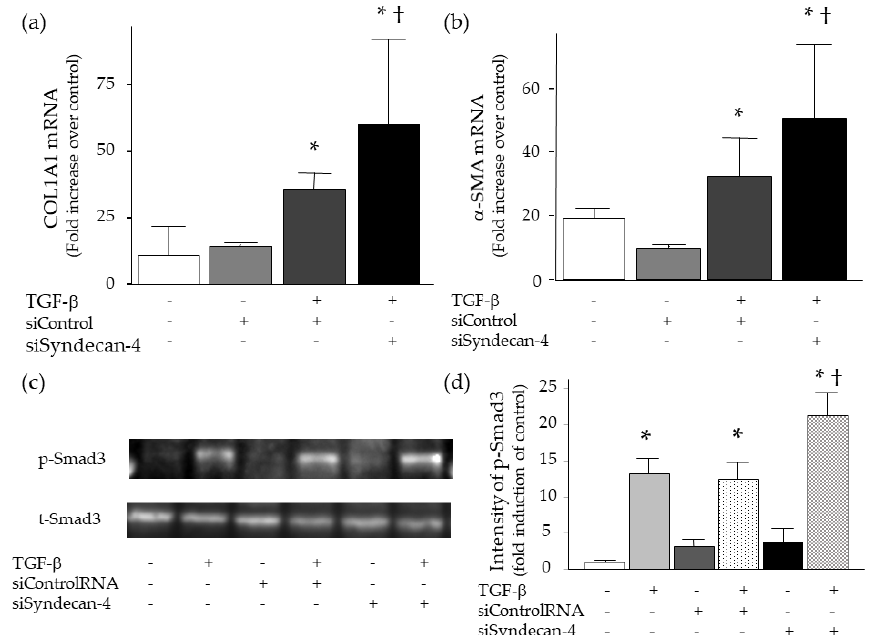
Figure 8. Expression of collagen, α -SMA and Smad3 in WI-38 lung fibroblasts after TGF- β stimulation with or without knockdown of syndecna-4. ( a , b ) TGF- β -induced type I collagen (COL1A1)